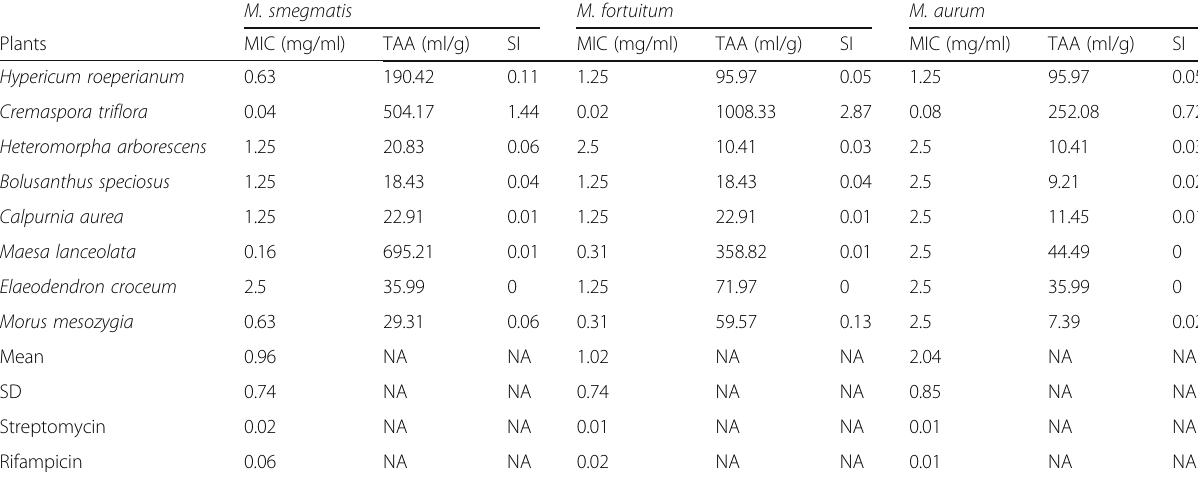
Table 1 Minimum inhibitory concentration (MIC) and total antimycobacterial activity (TAA) and selectivity index (SI) of the eight selected acetone leaf extracts against Mycobacterium smegmatis , Mycobacterium fortuitum , Mycobacterium aurum . The SI and TAA values of the extracts were calculated from the cytotoxicity and percentage yield of the extracts results published in Elisha et al. [21] M.